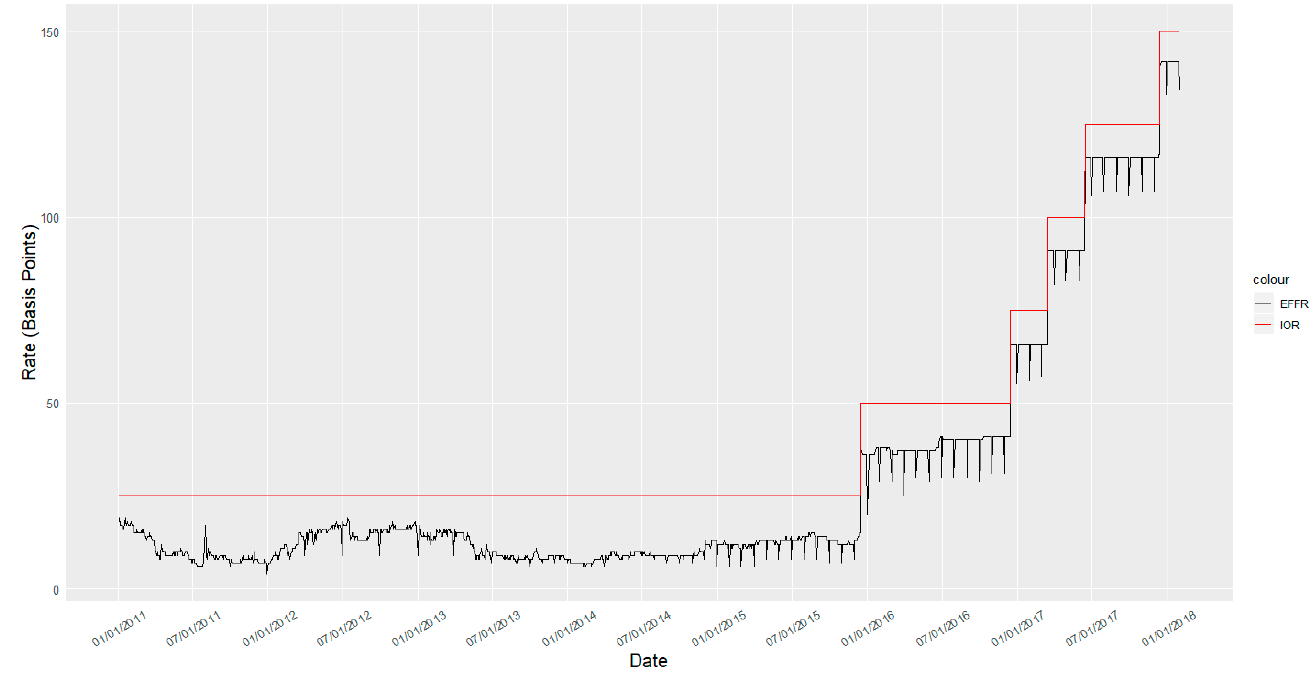
Figure 2. Time Series Plots of Effective Federal Funds Rate and the Interest Rate on (Excess and Required) Reserves.